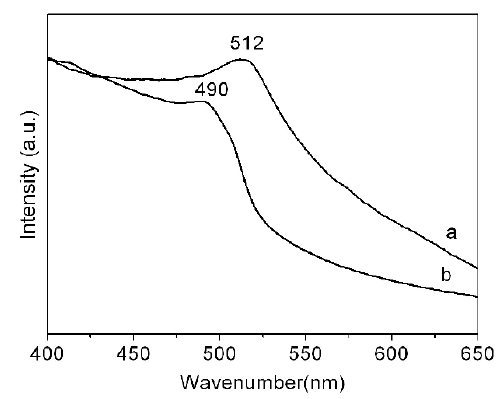
Figure 5. XRD patterns of the products with the temperatures: (a) 140 o C; (b) 180 o C, (c) 200 o C, and (d) 220 o C, respectively.